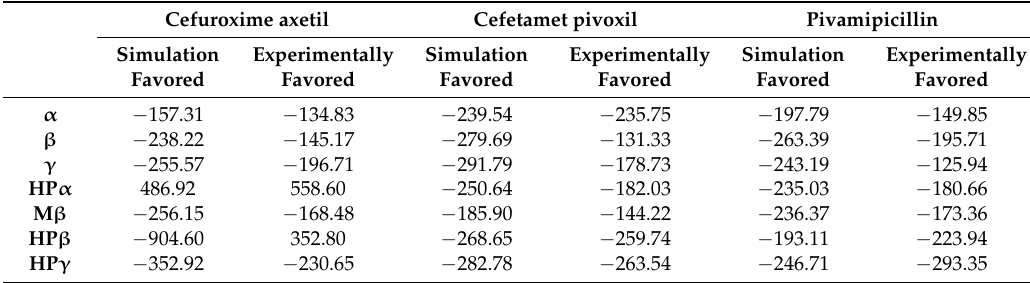
Table 2. Binding enthalpies of complexes conformations acquired according to machine learning results (experimentally favored) in relation to conformations favored in a simulated water environment.